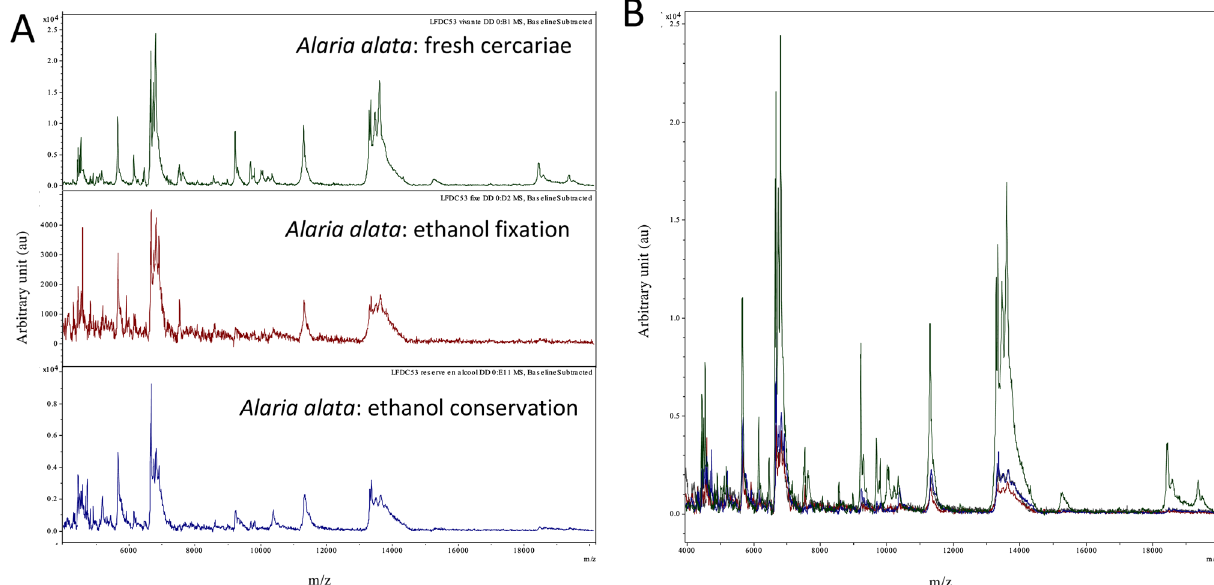
Figure 4. Panel A: Representative MALDI-TOF spectra of the same specimen (LFDC53) under the following conditions: fresh cercariae, ethanol fi xation, and ethanol conservation (12 months). Panel B: Superposition of panel A